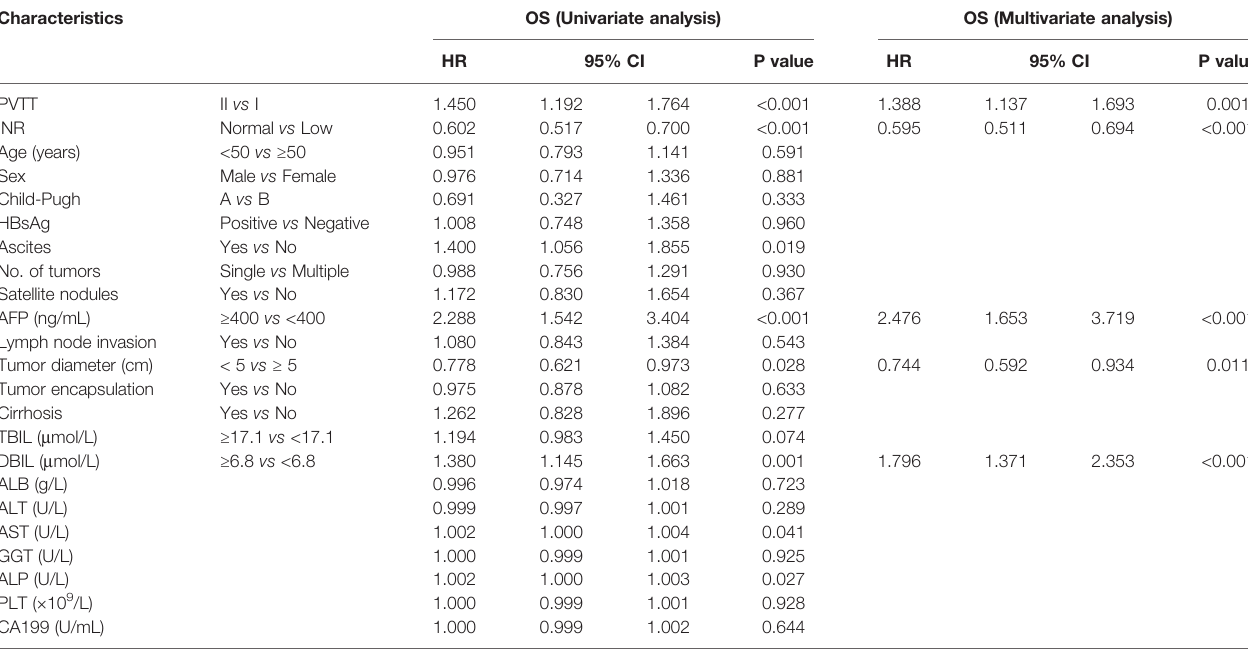
TABLE 2 | Univariate and multivariate analysis of overall survival of 592 patients with types I/ II PVTT who underwent R0 LR. Characteristics